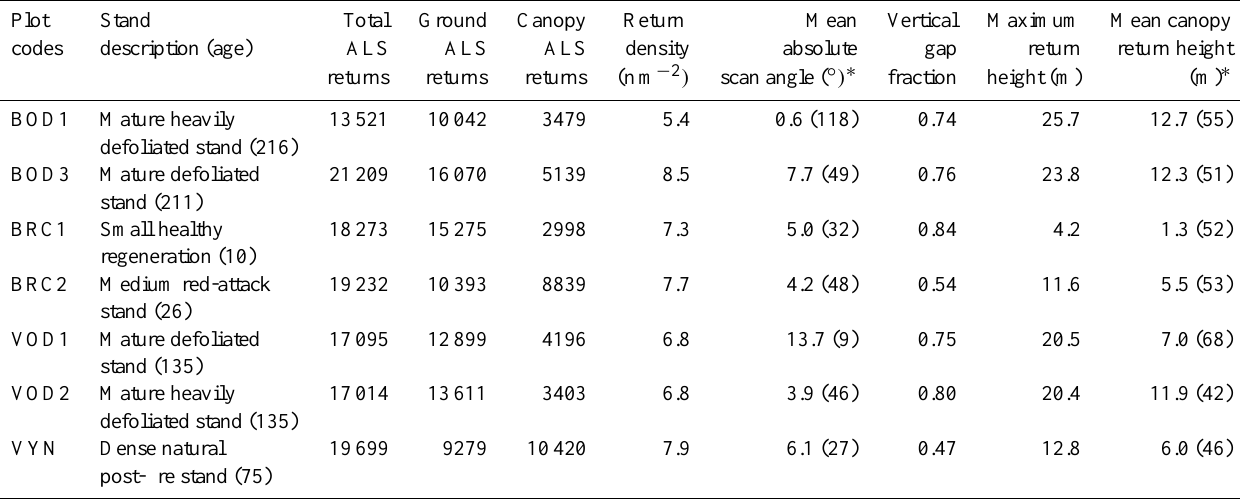
Table 2. ALS simple metric summary for each major plot. Plot Stand Total Ground Canopy Return Mean Vertical Maximum Mean